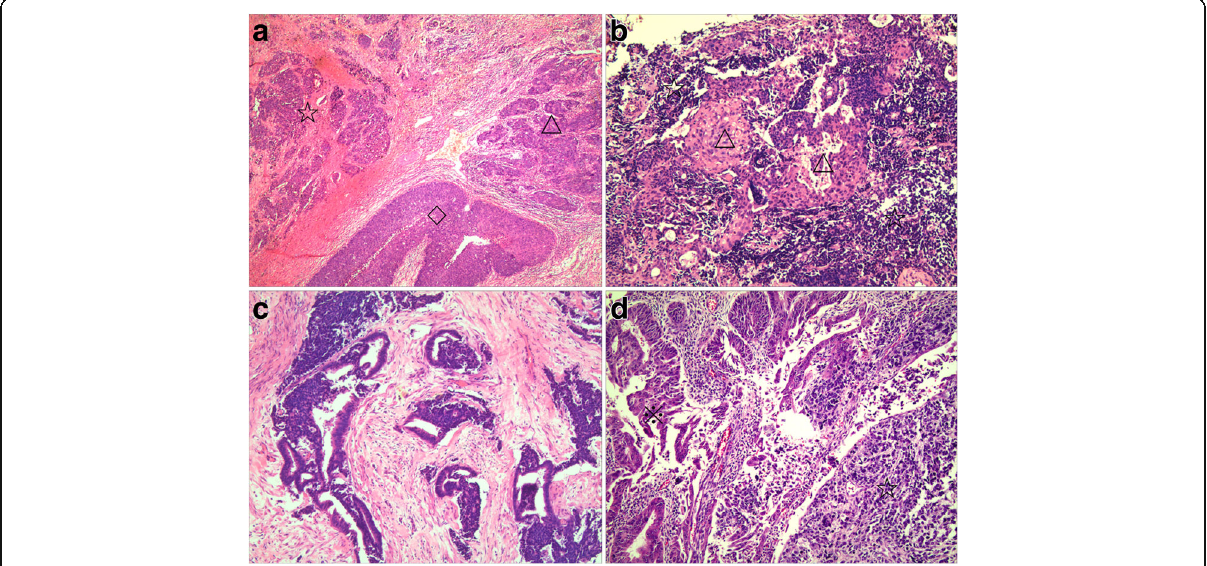
Fig. 1 Cervical small cell carcinoma associated with other types of epithelial tumors (hematoxylin-eosin staining). a Squamous cell carcinoma ( △ ) and squamous cell carcinoma in situ ( ◇ ) detected in the superficial parts of small cell carcinoma ( ☆ ) (× 40). b Squamous cell carcinoma ( △ ) intermingled with small cell carcinoma ( ☆ ) (× 100). c Small cell carcinoma ( ☆ ) mixed with adenocarcinoma ( ※ ) (× 100). d Adenocarcinoma ( ※ ) present at the periphery of small cell carcinoma ( ☆ ) (×